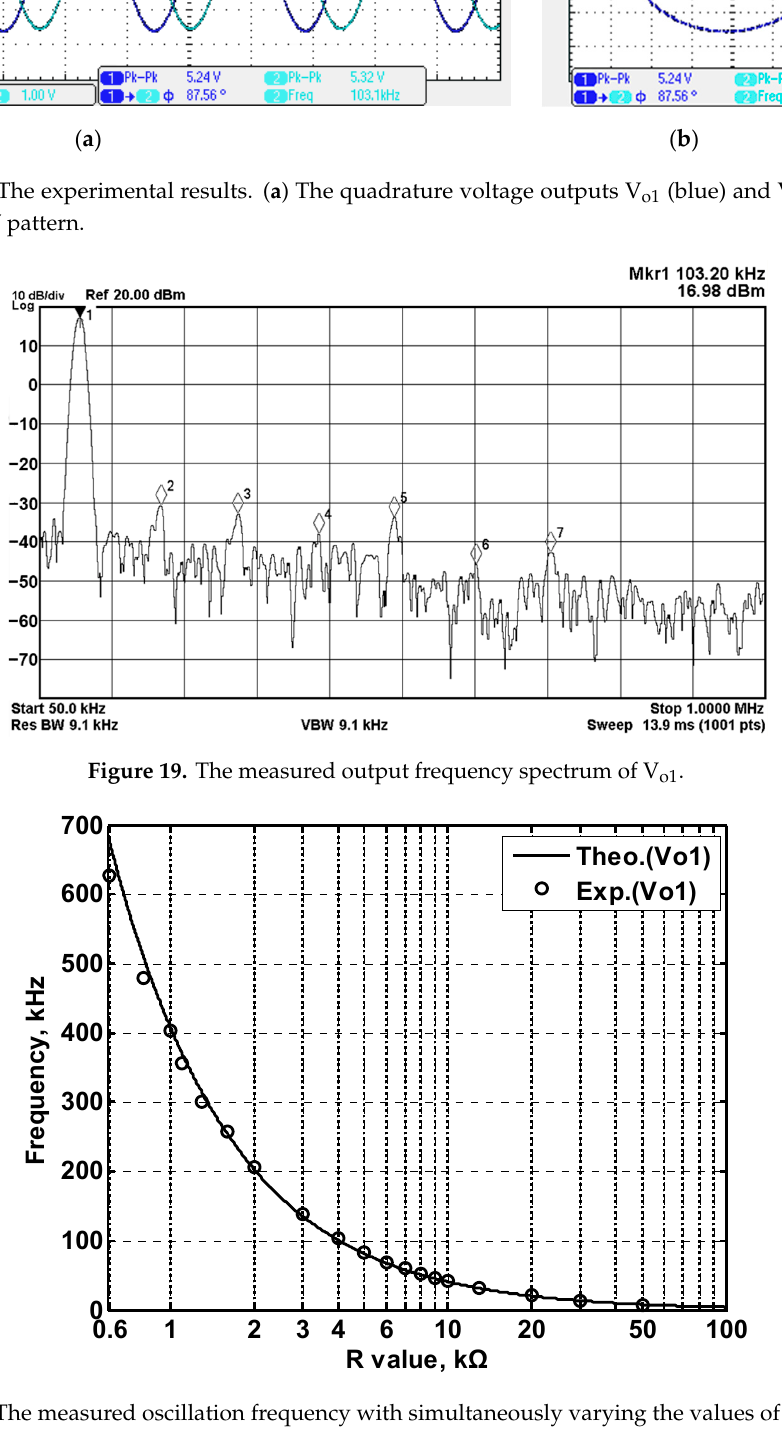
Figure 20. The measured oscillation frequency with simultaneously varying the values of R 1 and R 2 for the proposed VM quadrature oscillator in Figure 4.